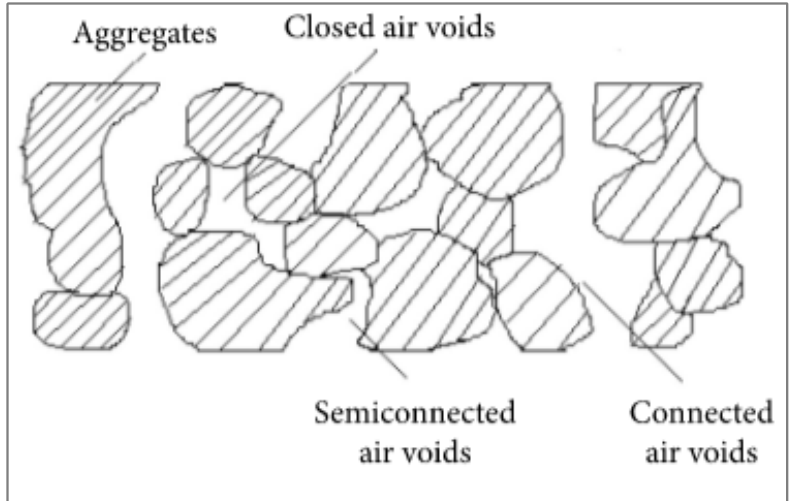
Figure 4. Schematic View of Air Content [55].